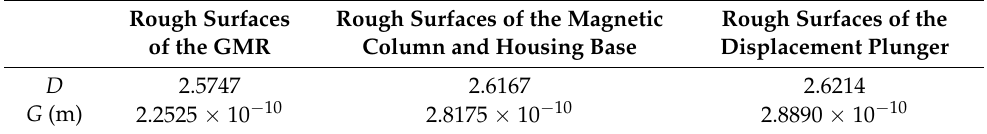
Table 2. Measurement parameters of the rough surfaces.